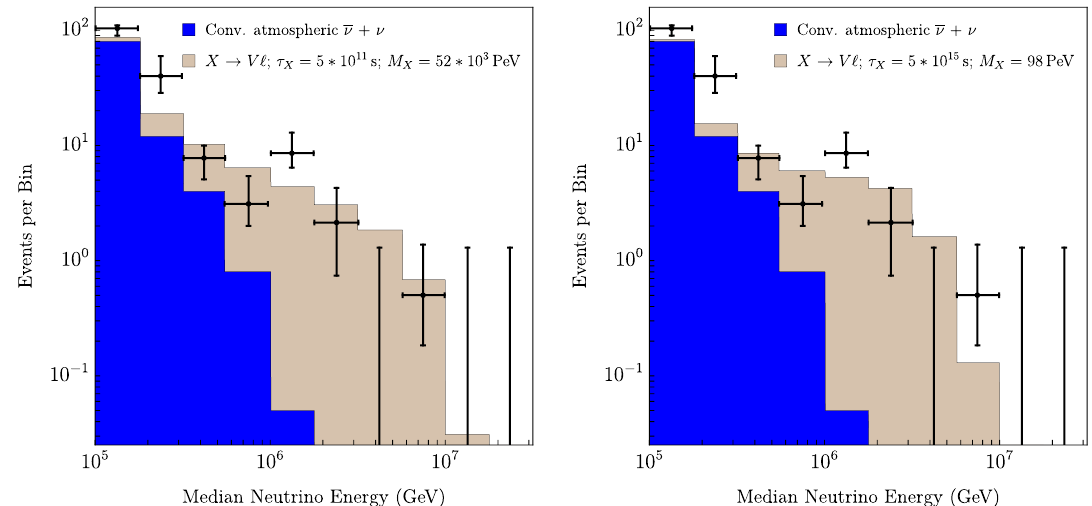
Figure 5 . Neutrino spectrum forecast from decay model II ( V ! V ‘ ) for two di(cid:11)erent allowed lifetimes. The displayed spectrum shows the best mass (cid:12)t in the range 0 : 3 PeV{10 PeV to the combined dataset for a short sample lifetime (cid:28) X (cid:28) X = 5 (cid:3) 10 15 s on the l